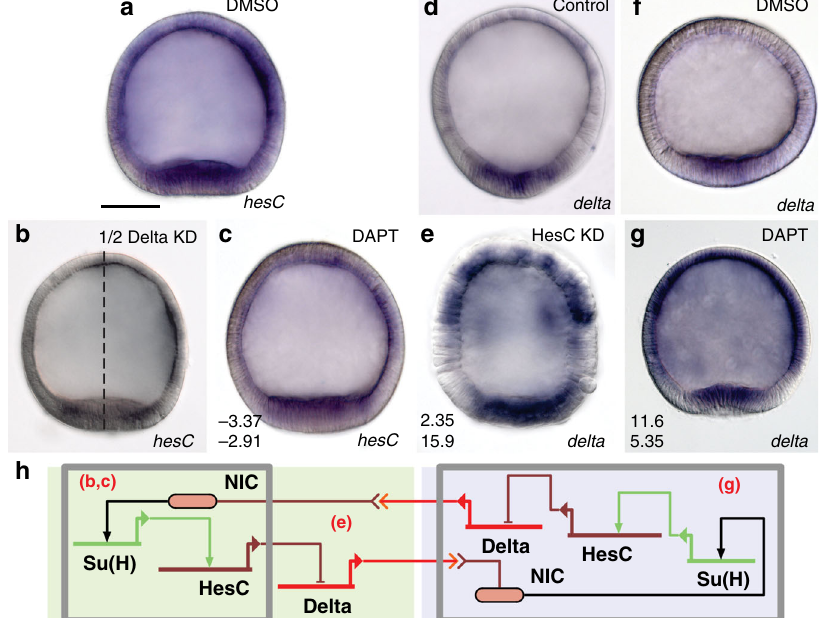
Fig. 2 Testing lateral inhibition of delta and hesC by inhibition of Notch signaling (DAPT) and morpholino knockdown (KD) of HesC. Using DAPT, an inhibitor of the proteolytic gamma-secretase necessary for notch signal transduction, we observe both a down-regulation of hesC ( c ) and an upregulation of delta transcripts ( g ). Importantly the down-regulation of hesC is phenocopied by injection of a morpholino targeting the delta transcript into one of the fi rst two blastomeres ( b ). Knockdown of HesC with an antisense morpholino yields an upregulation of both delta ( e ) and hesC transcripts. Lateral inhibition network showing relationships tested by previous experiments ( h ); red letters indicate fi gure panel above supporting connection. All images are colorimetric WMISH with the probes to the indicated genes. Images are representative of two biologically independent experiments consisting of at least ten embryos each. Scale bar represents 50 μ m; applicable to all images in the panel. Numbers in the lower left corner of ( c , e , and g ) represent normalized log2 fold-change values of perturbed expression compared with control (i.e., a , d , and f ) as measured by